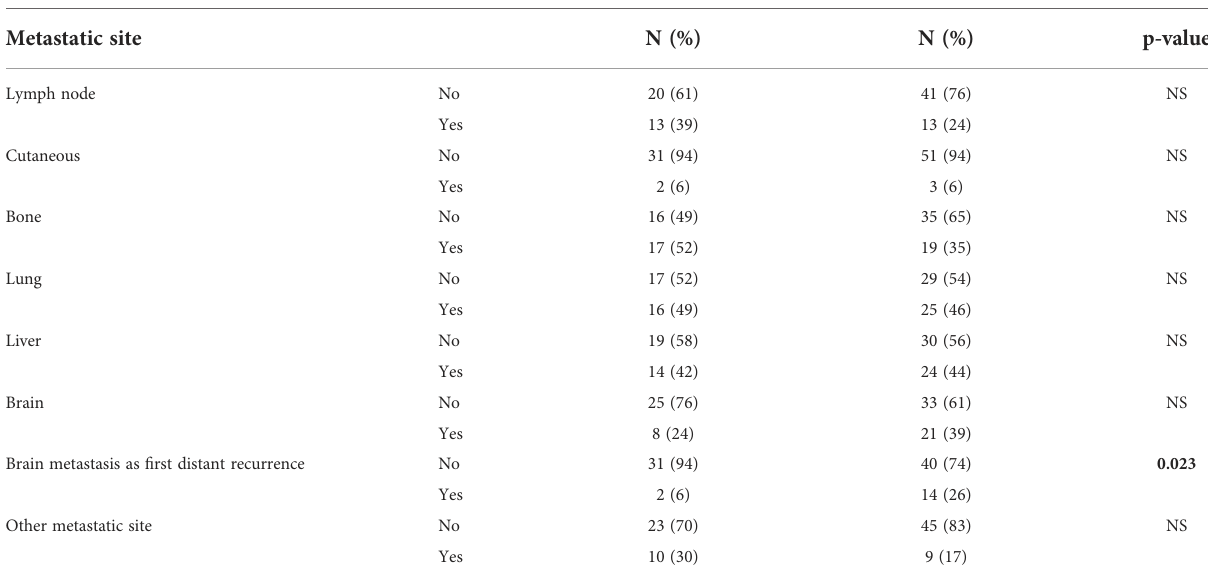
TABLE 4 Metastatic site for patients with distant